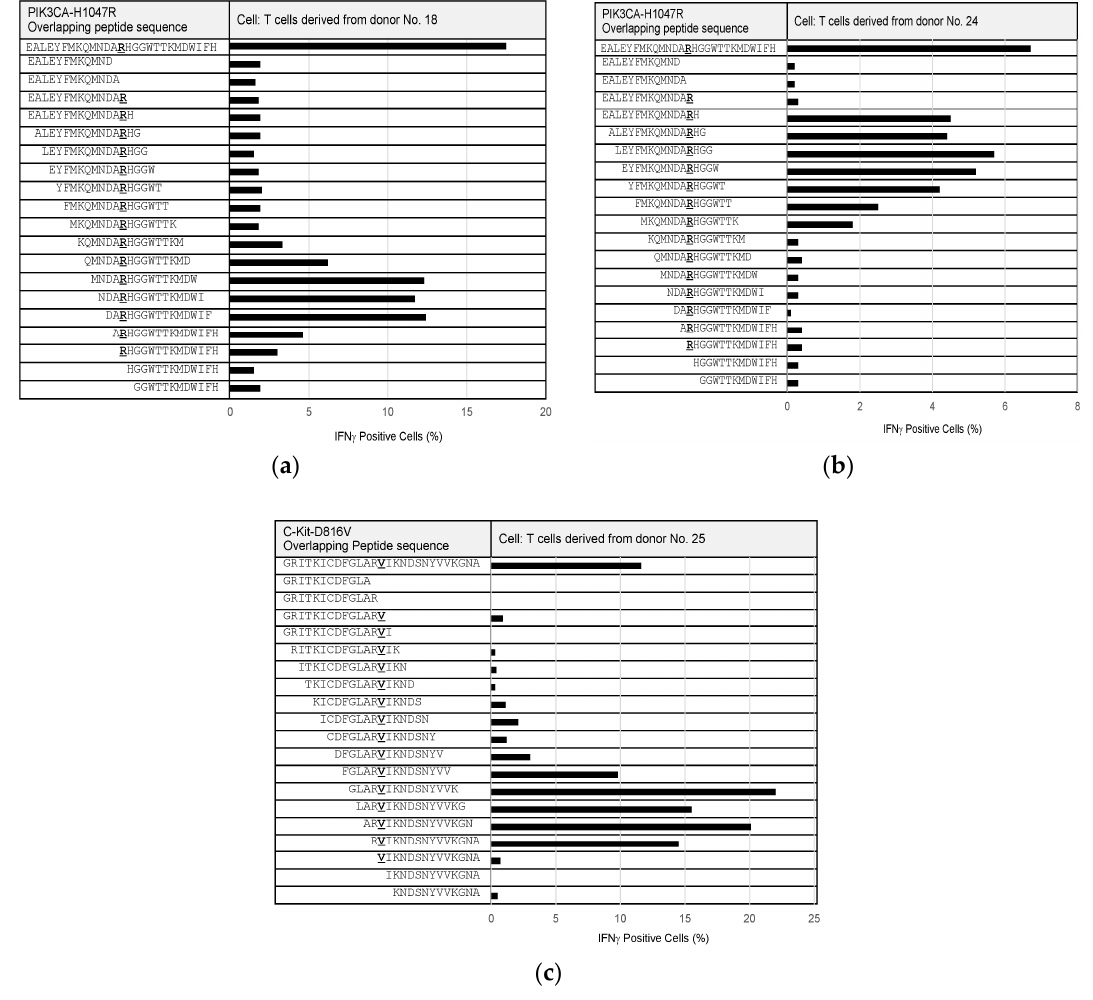
Figure 4. Epitope mapping of neoantigens. Overlapping peptides (12- to 15-mer) derived from PIK3CA-H1047R or C-Kit-D816V were tested for IFN γ production in CD4 + T cells specific to PIK3CA-H1047R or C-Kit-D816V, respectively. The percentages of IFN γ positive cells in neoantigen-specific CD4 + T cells were determined by flow cytometry after stimulation with each overlapping peptide, presented by autologous DCs as APCs. The sequences of overlapping peptides and percentages of IFN γ positive cells in CD4 + T cells are shown. ( a ) PIK3CA-H1047R-specific CD4 + T cells from donor No. 18; ( b ) PIK3CA-H1047R-specific CD4 + T cells from donor No. 24; and ( c ) C-Kit-D816V-specific CD4 + T cells from donor No. 25.